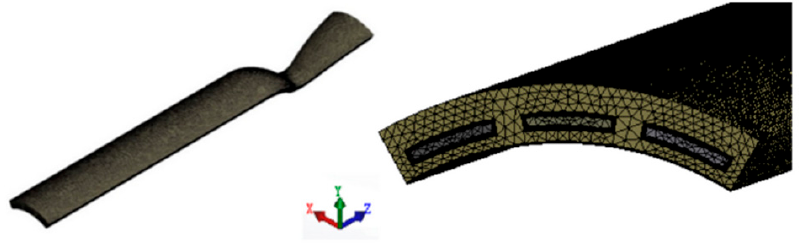
Figure 7. Regenerative cooling channel mesh and local enlargement.